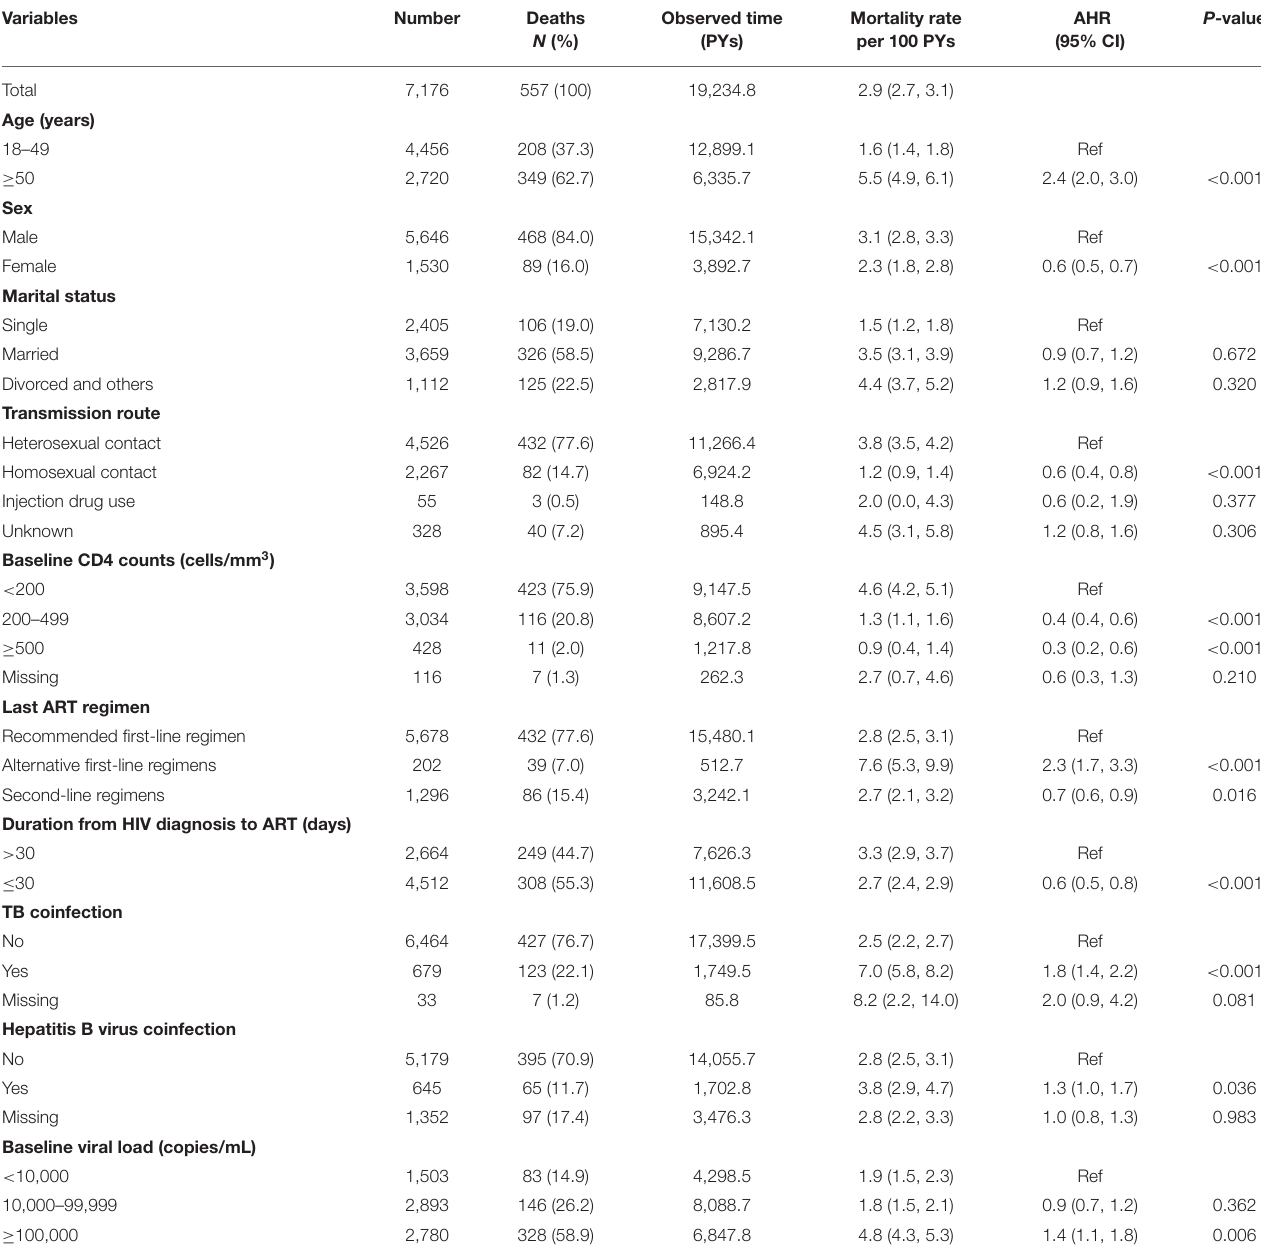
TABLE 2 | Effects of baseline viral load on death among HIV patients initiating ART in Chongqing, China, 2015–2019.